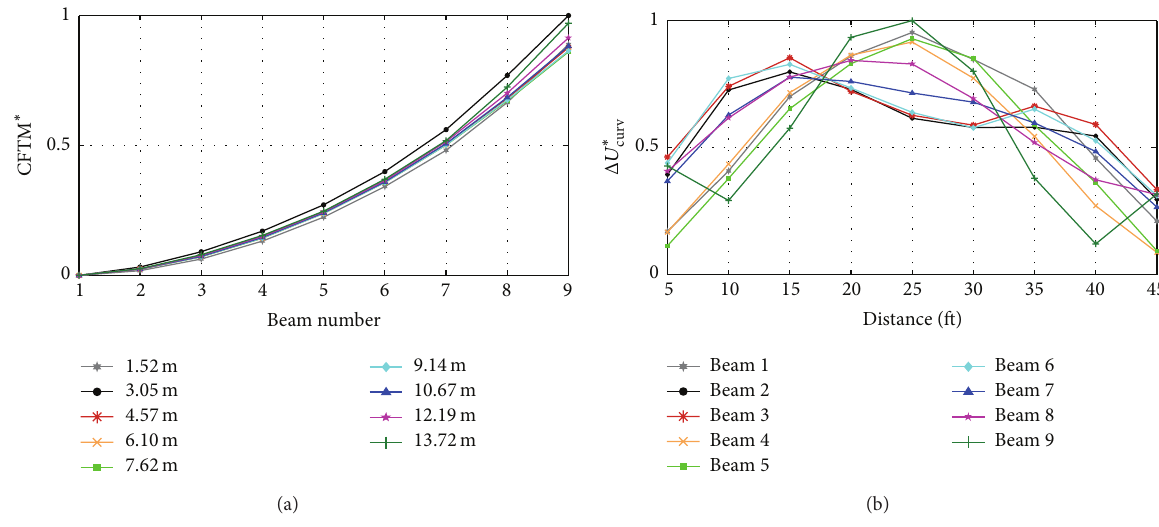
Figure 10: Plot of (a) CFTM ∗ and (b) Δ𝑈 ∗